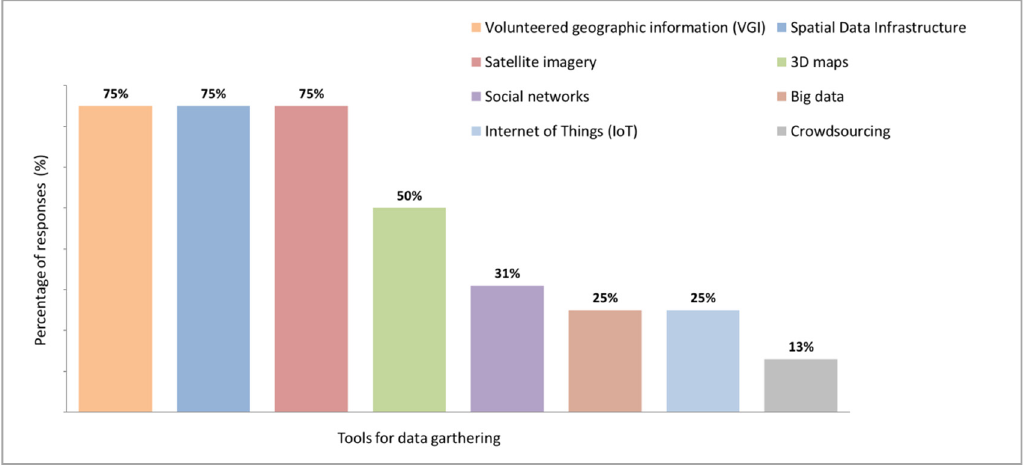
Figure 9. Recommended tools for improving EIGEO data gathering (Q24). Note: Multiple answers allowed.